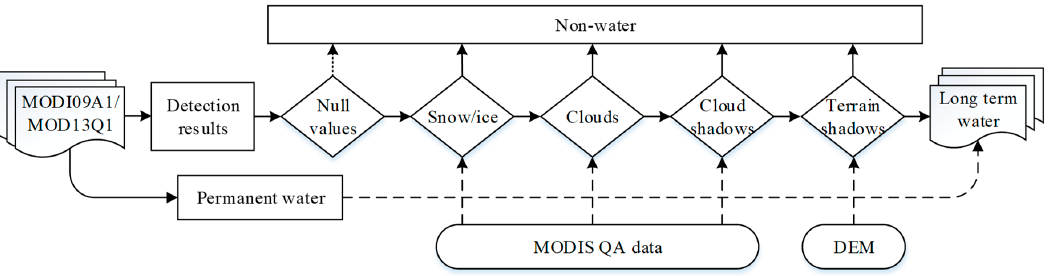
Figure 4. Water extraction result correction.